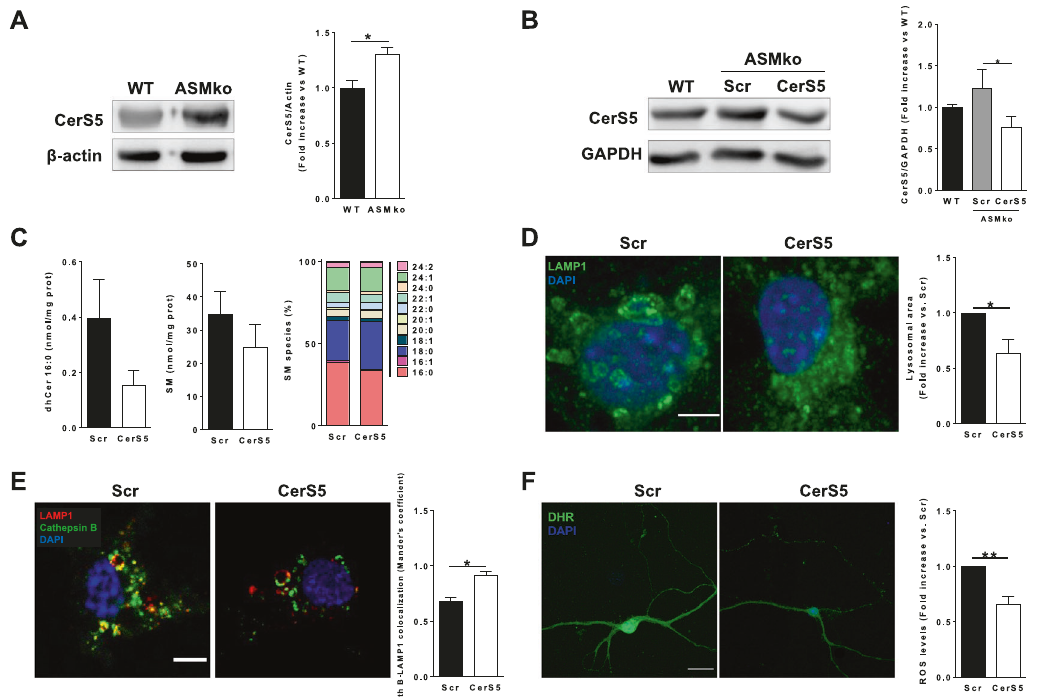
Fig. 5 Bene fi cial effects of CerS5 genetic silencing in ASMko cultured neurons. A Western blot images of the levels of CerS5 and β -actin in cerebellar extracts of wt and ASMko mice. Graph shows mean ± SEM CerS5 protein expression in the ASMko cerebellar extracts normalized to β -actin and expressed as fold-increase with respect to wt extracts ( n = 3; * p < 0.05). B Western blot images of the levels of CerS5 and GAPDH in non-infected wt cultured neurons or in ASMko cultured neurons infected with adenovirus containing either shRNA-CerS5 or shRNA-scramble. Graph shows mean ± SEM CerS5 protein expression normalized to GAPDH and expressed as fold-increase with respect to wt cultures ( n = 3; * p < 0.05). C Graphs show mean ± SEM levels of dihydroCeramide 16:0 (left panel) and total SM (middle panel) expressed as nmol/mg protein or mean percentages of SM species with respect to total SM (right panel) in cultured ASMko neurons infected with adenovirus containing either shRNA-CerS5 or shRNA scramble ( n = 4 independent cultures). D Immunocytochemical analysis against the lysosomal marker LAMP1 in cultured ASMko neurons infected with adenovirus containing either shRNA-CerS5 or shRNA-scramble. Graph shows mean ± SEM lysosomal area expressed as fold-change with respect to the shRNA-scramble infected cultures ( n = 4 independent cultures; * p < 0.05). DAPI staining shows cell nuclei. Bar = 5 µm. E Immunocytochemical analysis against the lysosomal resident protein Cathepsin B and the lysosomal marker LAMP1 in cultured ASMko neurons infected with adenovirus containing either shRNA-CerS5 or shRNA-scramble. Graph shows mean ± SEM Mander ’ s colocalization coef fi cient between Cathepsin B and LAMP1 ( n = 3 independent cultures; * p < 0.05). DAPI staining shows cell nuclei. Bar = 5 µm. F Representative images of DHR staining in cultured ASMko neurons infected with adenovirus containing either shRNA-CerS5 or shRNA-scramble. Graph shows mean ± SEM DHR intensity, proportional to ROS levels, expressed as fold-change with respect to shRNA- scramble infected cultures ( n = 4 independent cultures; ** p < 0.01). DAPI staining shows cell nuclei. Bar = 20 compounds that speci fi cally inhibit this enzyme are not currently available, we assessed its genetic inhibition by RNA silencing. To this aim we infected ASMko cultured cortical neurons with adenovirus containing either shRNA-CerS5 or shRNA-scramble as a control. The ef fi cacy of the treatment was con fi rmed by the 1.6-fold reduction in the CerS5 levels found by Western Blot in the shRNA-CerS5 compared to the shRNA- scramble infected ASMko cultures (Fig. 5B). This strategy rendered CerS5 amount in ASMko neurons to levels similar to those found in wt neurons (Fig. 5B). We also observed a 2-fold decrease in the levels of dihydroceramide16:0, which is a direct metabolite of CerS5 (Fig. 5C). In support of the targeting of the CerS5 silencing on SM16:0, this approach reduced by 1.2-fold the levels of this SM species in ASMko neurons and raised SM18:0 by 1.2-fold. It had no effect on SM24:1 (Fig. 5C). Total levels of SM were also not signi fi cantly changed by CerS5 silencing (Fig. 5C). Lysosomal parameters were analyzed to determine the effect of the treatment in these organelles. CerS5 silencing reduced lysosomal size (1.6-fold) (Fig. 5D) and lysosomal permeabilization measured by co-localization of CathepsinB-LAMP1 (1.3-fold) (Fig. 5E) in ASMko cultured neurons. The treatment also diminished oxidative stress (1.5- fold reduction in DHR intensity) (Fig. 5F).